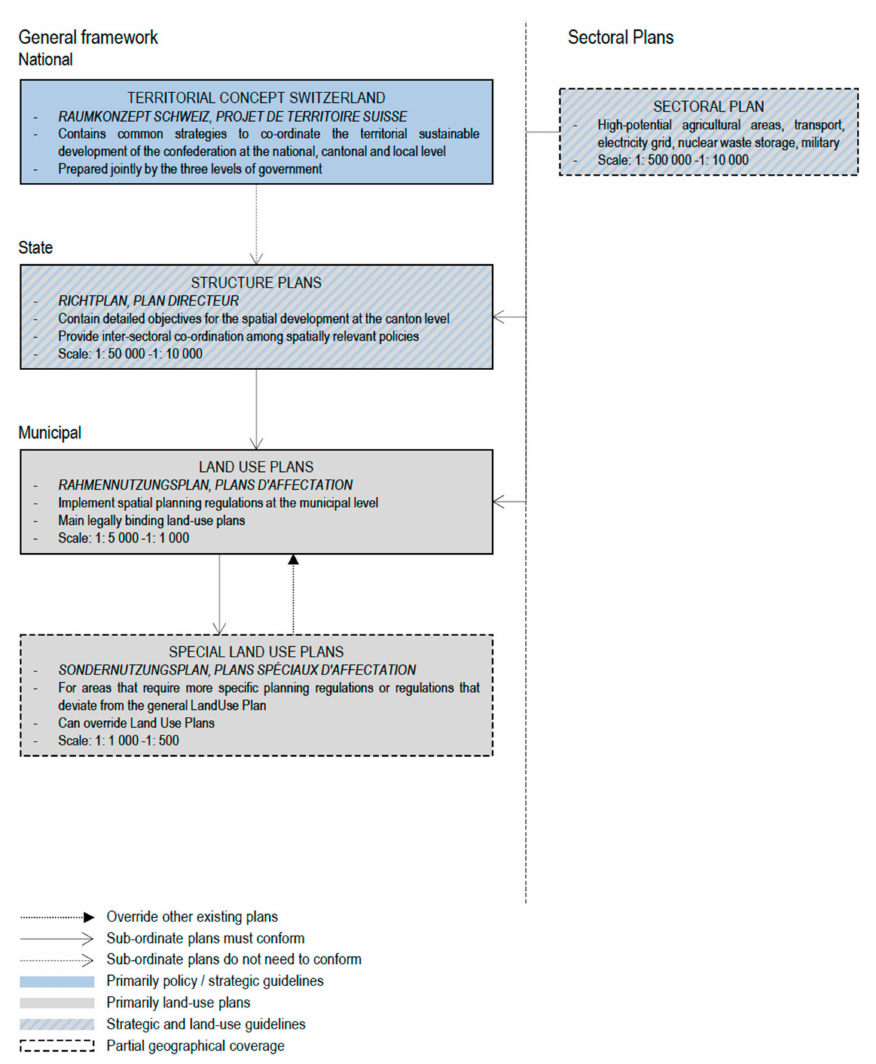
Figure 5. Organisation of spatial and land use planning in Switzerland